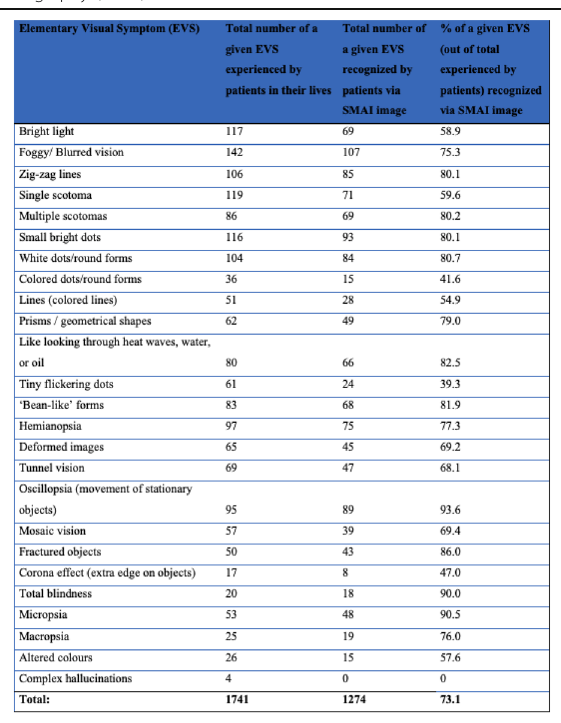
Table 1 (abstract A39). Occurence of each Elementary Visual Symptom (EVS) as experienced by patients in their lives and as recognized by patients via images included in the Standardized Migraine Aura Iconography